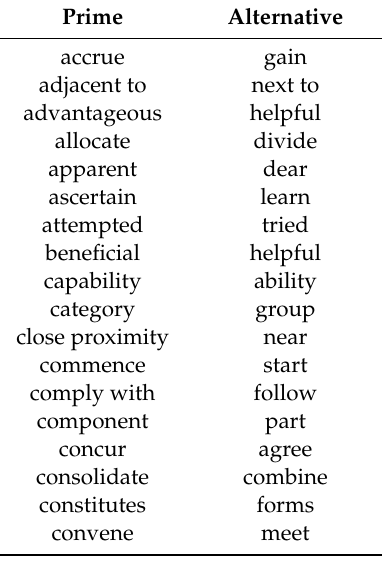
Table 4. Sample complex words with a simple alternative.